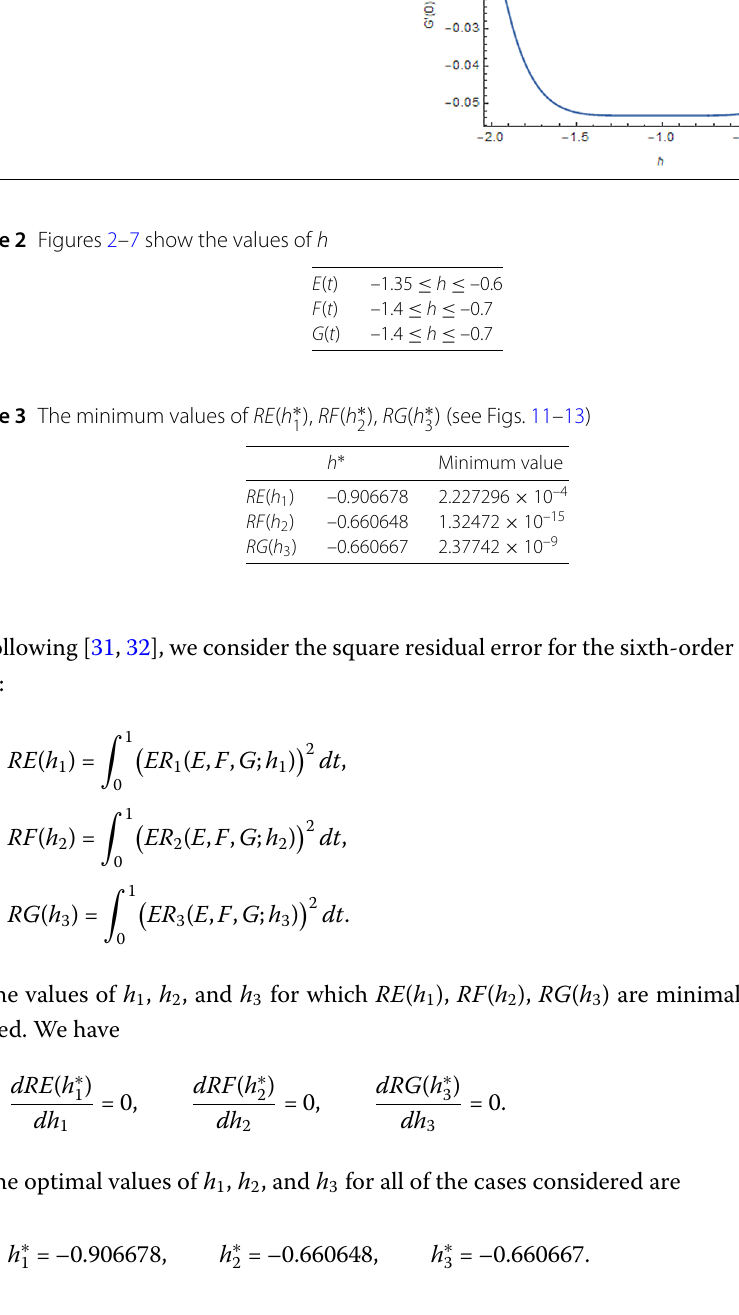
Figure 7 The h -curves of G (cid:10) (0) obtained by 6th-order approximation of the HAM